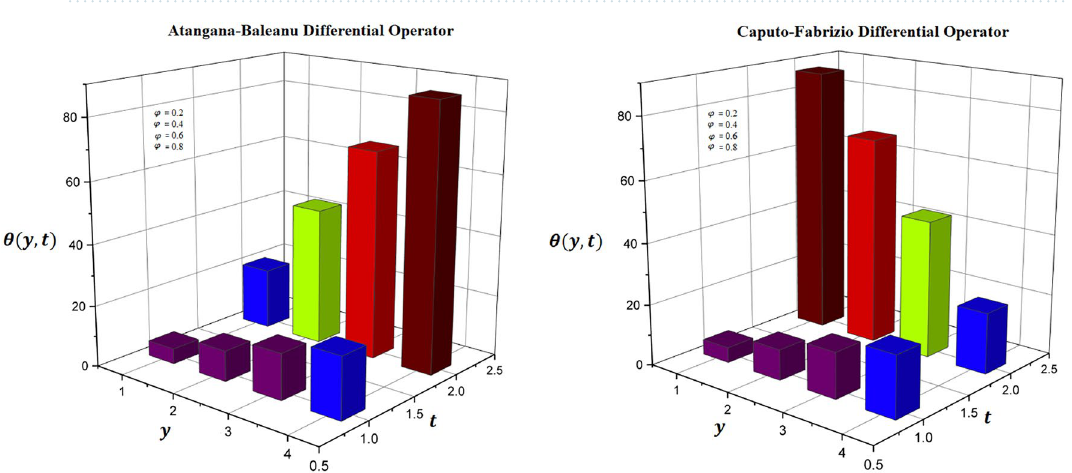
Figure 2. Variation of volume fraction for contour temperature distribution through AB-differential operator verses CF-differential operator.